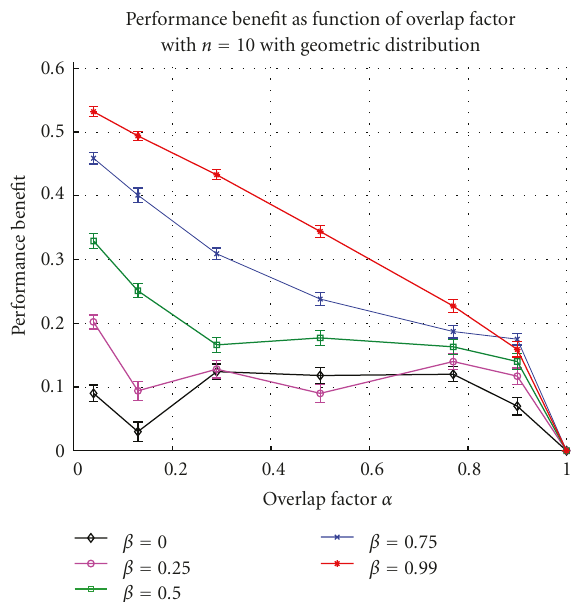
Figure 13: Performance gain through simulation for n = 5 for di ff erent values of geometric distribution parameter β as function of overlap factor, α.